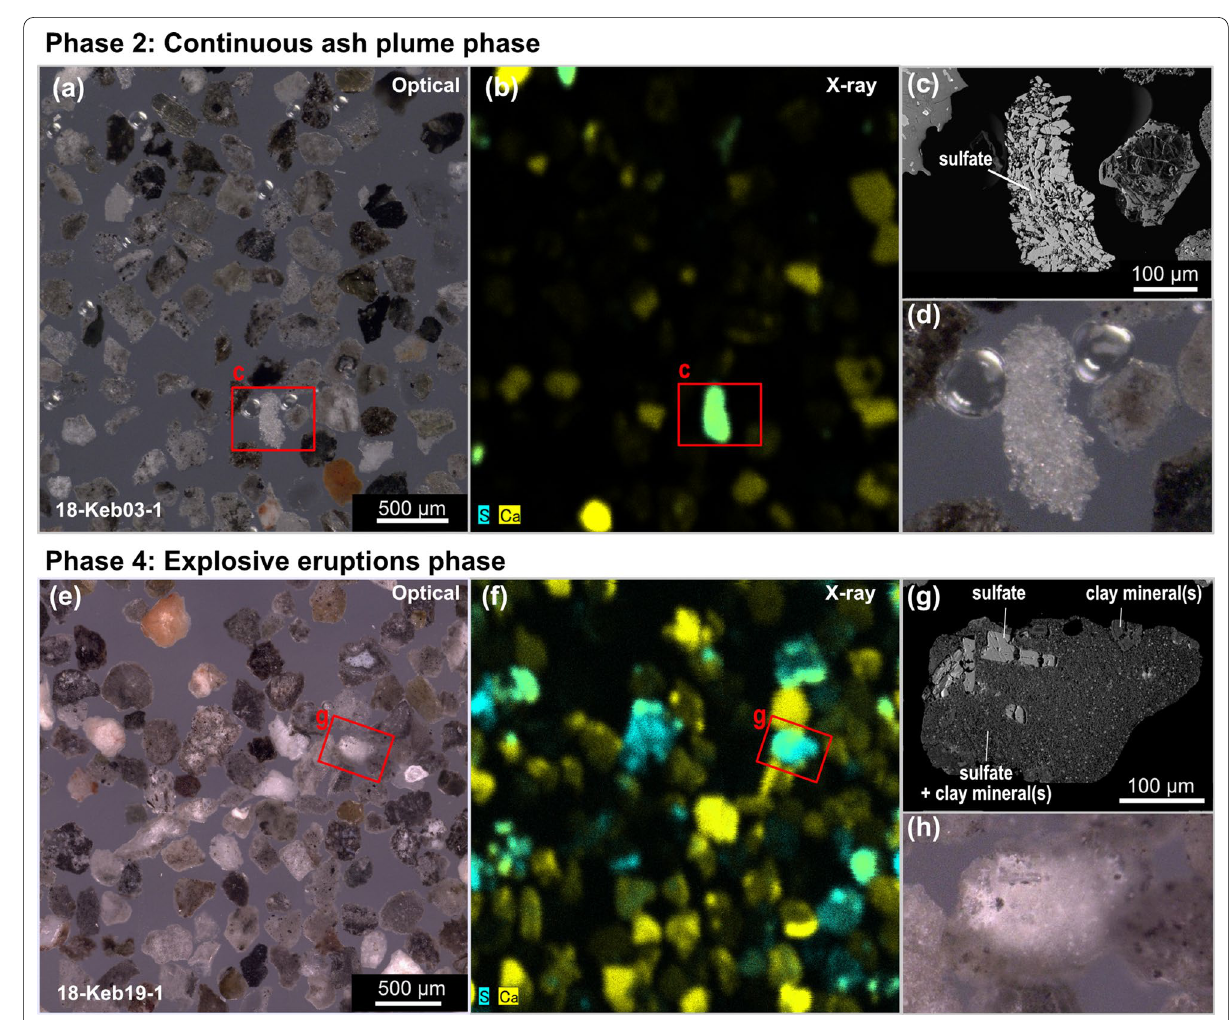
Fig. 7 Representative ash samples from Phase 2 ( a – d ) and Phase 4 ( e – h ) indicated by optical ( a , d , e , h ), X-ray ( b and f ) and backscattered electron ( c and g ) images. c , d A coarse euhedral sulfate crystal typical in Phase 2. g , h A fine euhedral sulfate crystals typical in Phase